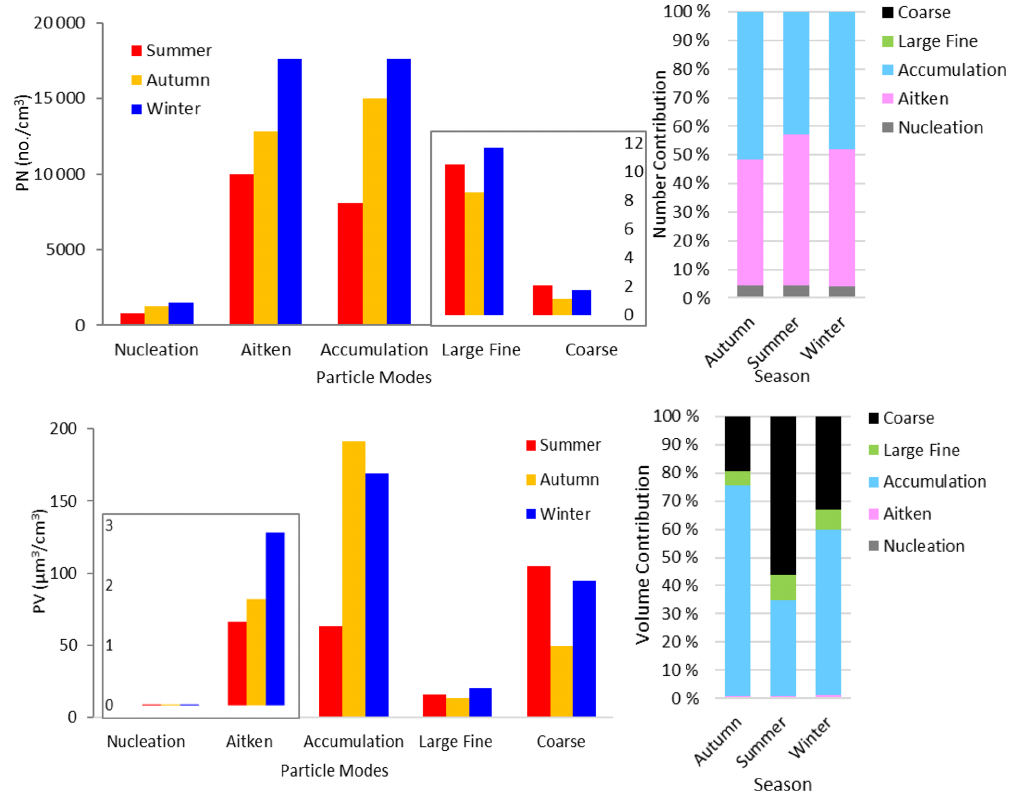
Figure 1. Comparison of average particle number counts (number per cm 3 ) for nucleation, Aitken, accumulation, large fine and coarse modes of PM between 15nm and 10µm in all seasons, and the volume contributions for